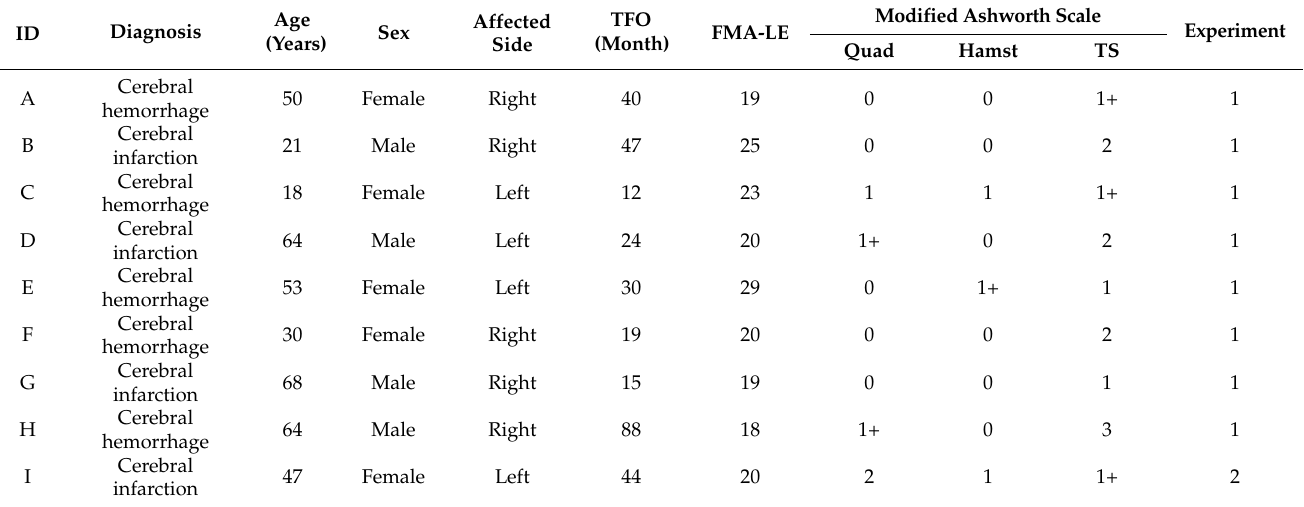
Table 1. Patients’